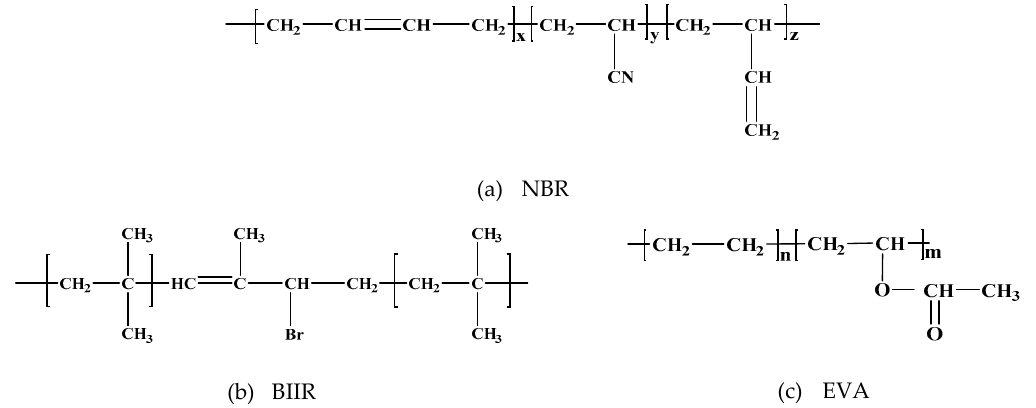
Figure 1. Molecular structural formulas: (a) nitrile rubber (NBR); (b) brominated butyl rubber (BIIR); (c) ethylene ‐ vinyl acetate (EVA).